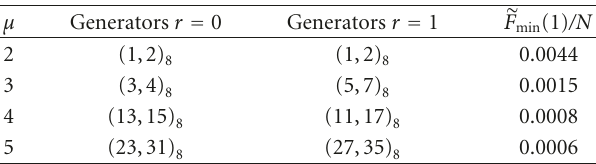
Table 1: Optimum overlays for rate 1 / (2 R ) COP-STC with BPSK, n = 2, m = 1, R = 1, in quasistatic channel. The basic code for a single transmitter is STC as in